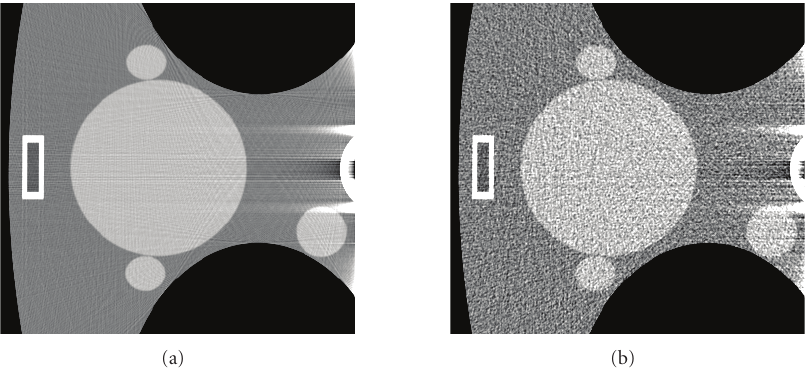
Figure 5: Reconstructed results in the rectangular ROI indicated in Figure 4(a) using the approach developed by Defrise et al. (a) Recon- structed ROI from noise-free data, and (b) the counterpart from noisy data. The display window is